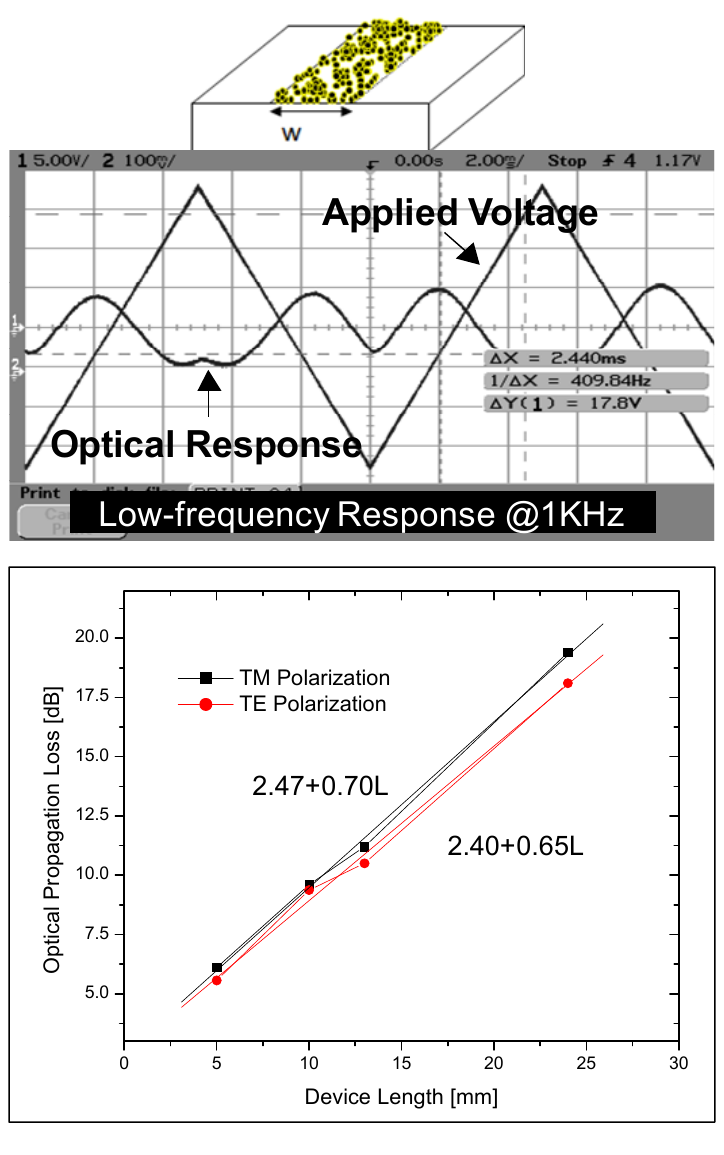
Figure 9. The electro-optic modulation and optical loss characteristics are shown for a nanostructured gold thin (1 nm) film IMI structure. The optical propagation loss was observed to be 0.65–0.70 dB/mm at 1,550 nm. The measured insertion loss was 14